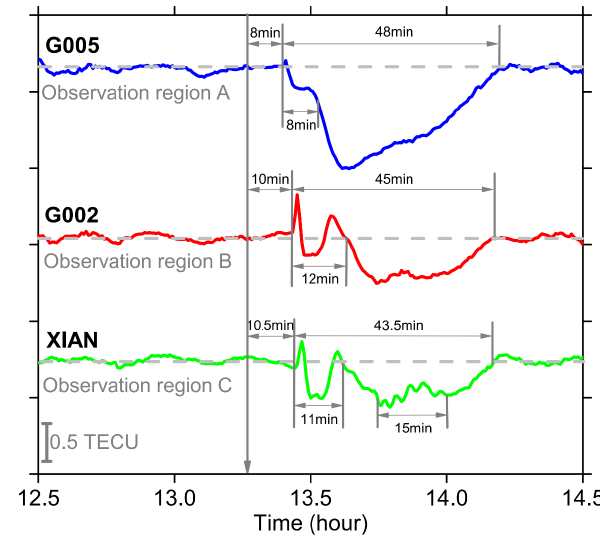
Figure 7. Time characteristics of the ionospheric disturbance vari- ability after launching Tiangong-1 in three observation regions A, B and